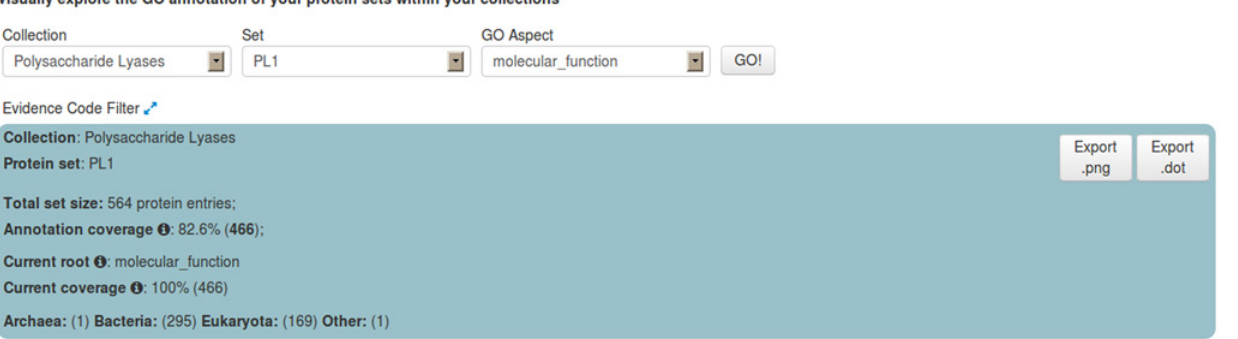
PLOS ONE | DOI:10.1371/journal.pone.0119631 March 20,